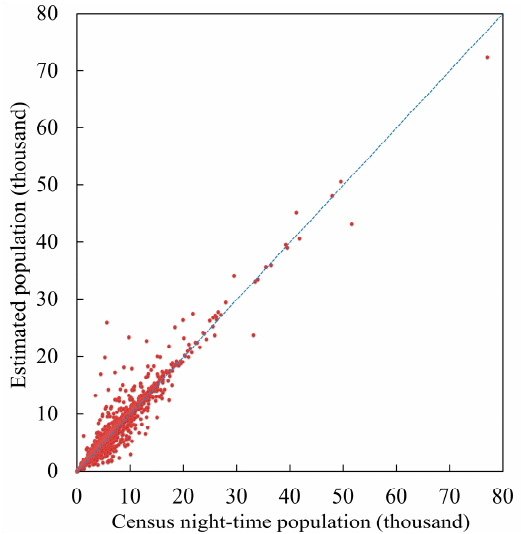
Figure 6. Census night-time population compared with the estimated night-time population based on the dynamic population model at the community level.